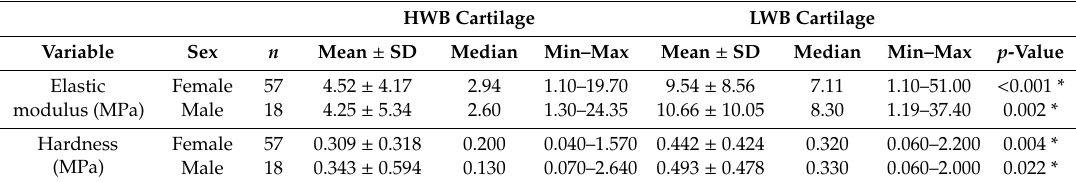
Table 4. Elastic modulus and hardness of high weight bearing (HWB) and low weight bearing (LWB) articular cartilage adjusted to patients’ ages.